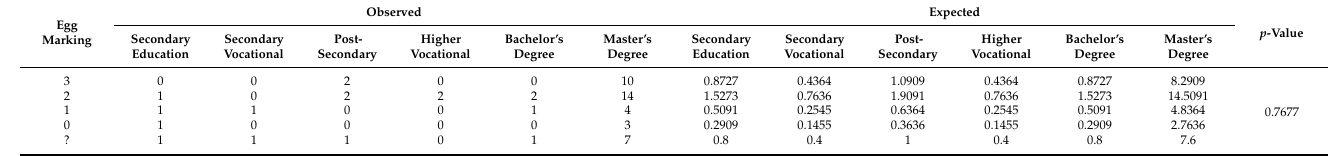
Table 5. The egg marking choices according to the educational level of the